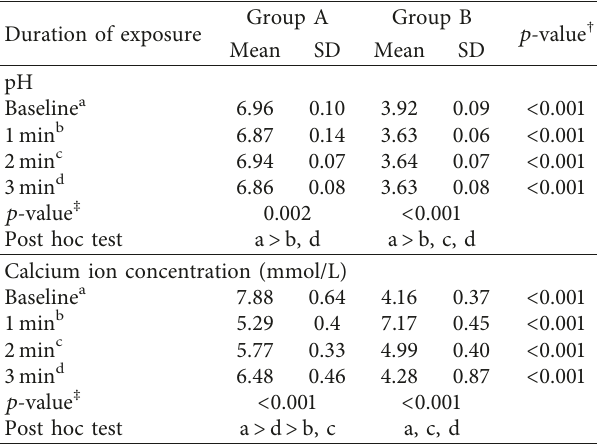
Table 1: Inter- and intragroup comparisons of pH and calcium ion concentration in groups A and B. Duration of